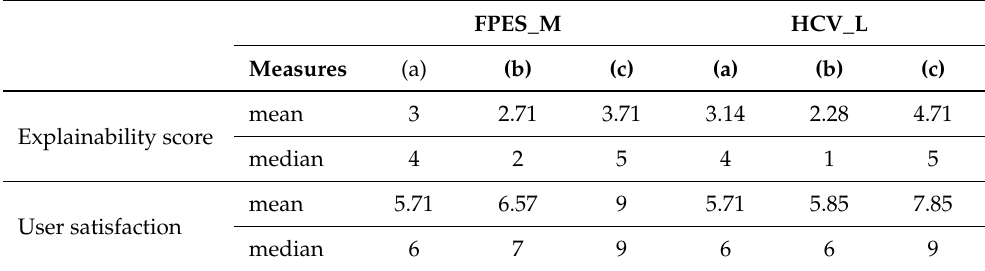
Table 6. Mean and median values of explainability score and user satisfaction for the fault types “fan pressure sensor not working” (FPES_M) and “heating coil valve leakage” (HCV_L) using three different types of